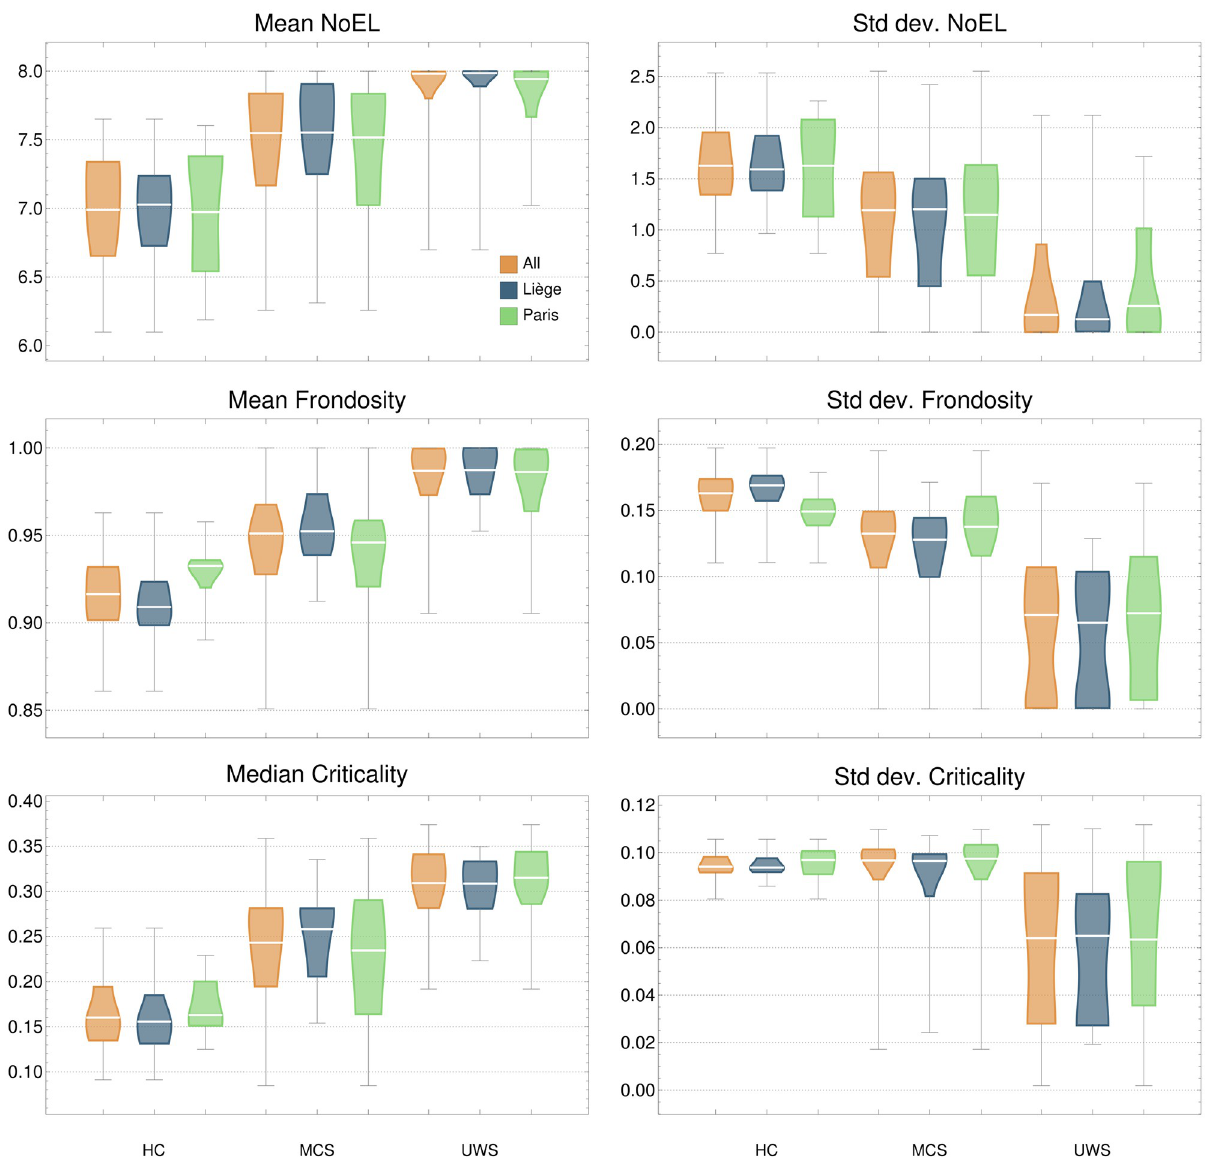
Fig 4. Distributions of NoEL, frondosity and criticality. Each subject brings one value to the distributions (the mean or standard deviation of the corresponding measure across time). Standard deviation of NoEL can be considered a measure of metastability, since it reflects the tendency of the system to change the attractors. Frondosity is related to integration: IS with low frondosity exhibit greater cooperative interactions between nodes (see the cooperation measures on Fig 6). Mean frondosity values very close to 1 (like those of UWS patients) denote a lack of integration in brain activity, since maximum frondosity coincides with the absence of cooperative nodes. Criticality indicates how close is the system to a major change on the attractor shape (affecting the GASS). The lower the criticality, the closer the system is to a bifurcation point and the easier it is for the IS to undergo large changes. The median criticality distributions show that the IS of healthy subjects move closer to bifurcation